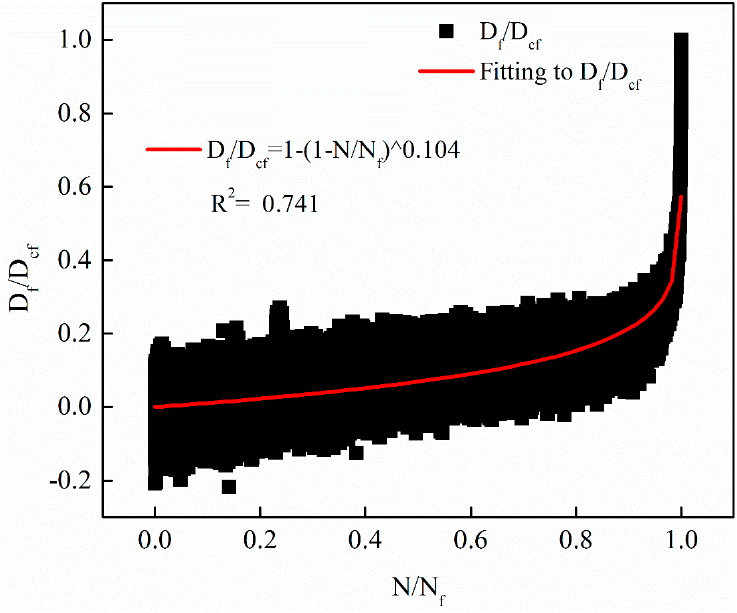
Figure 14. The evolution curves with stress levels of 0.25 MPa. Materials 2019 , 12 , x FOR PEER REVIEW